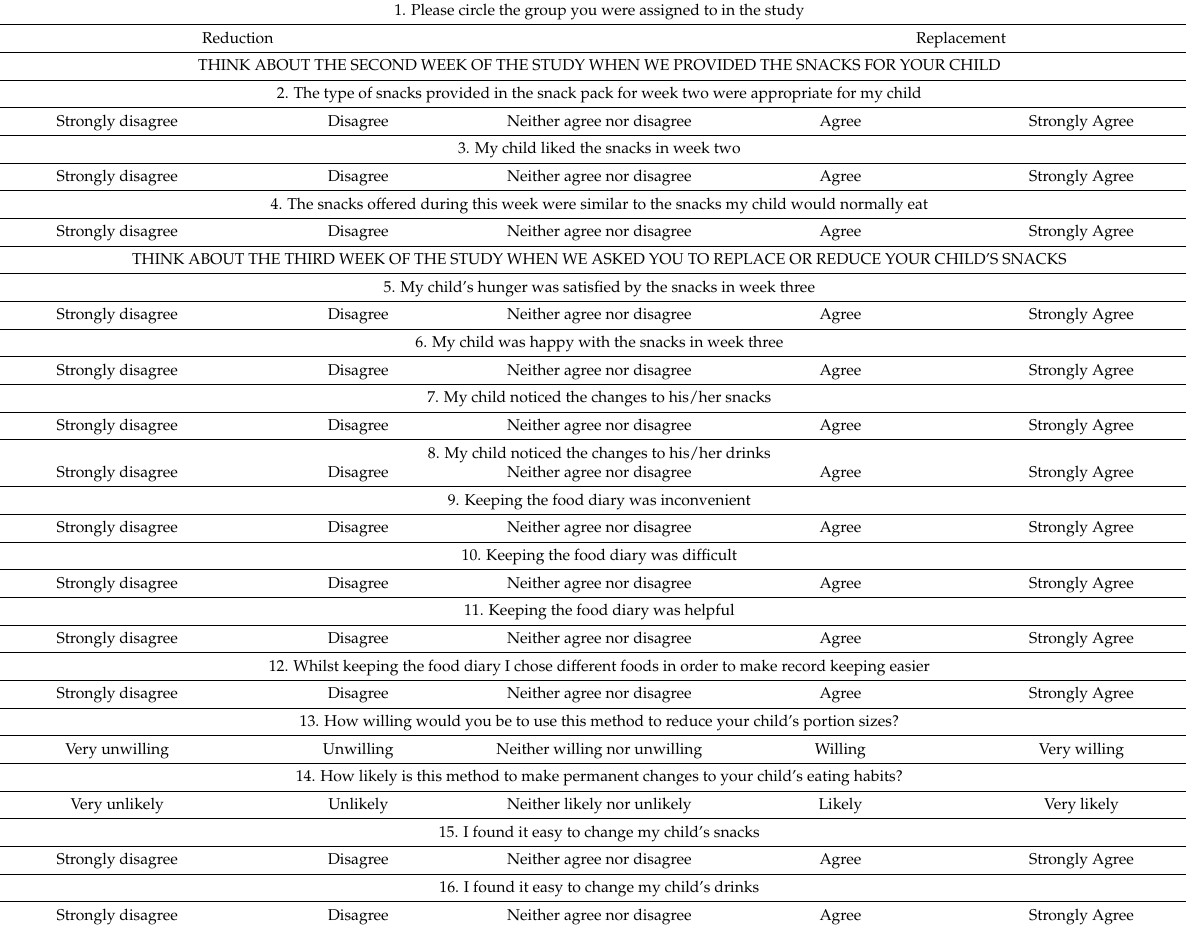
Table A1. Acceptability